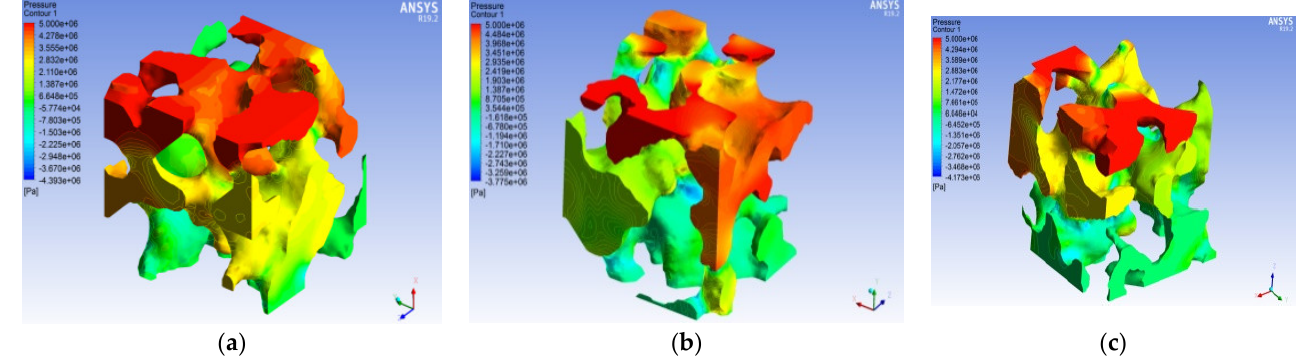
Figure 10. X, Y, and Z positive single channel seepage pressure distribution. ( a ) X positive direction, ( b ) Y positive direction, and ( c ) Z positive direction.